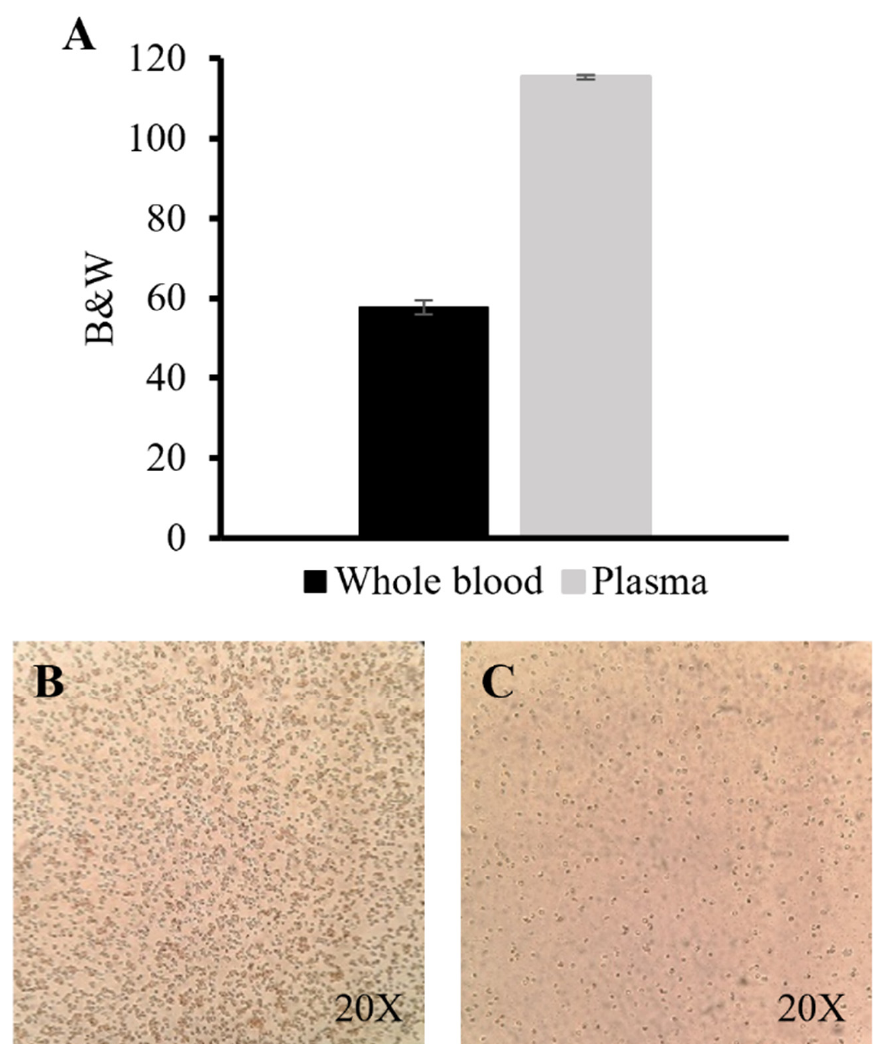
Figure 6. Qualitative assessment of the separated plasma through image analysis. ( A ) Black and white (B&W) analysis of whole blood (dark gray) and the separated plasma (light gray), where 0 = black and 255 = white ( n = 3). Images at 20× magnification of a whole blood ( B ) and a separated plasma ( C ) sample drop on a slide.